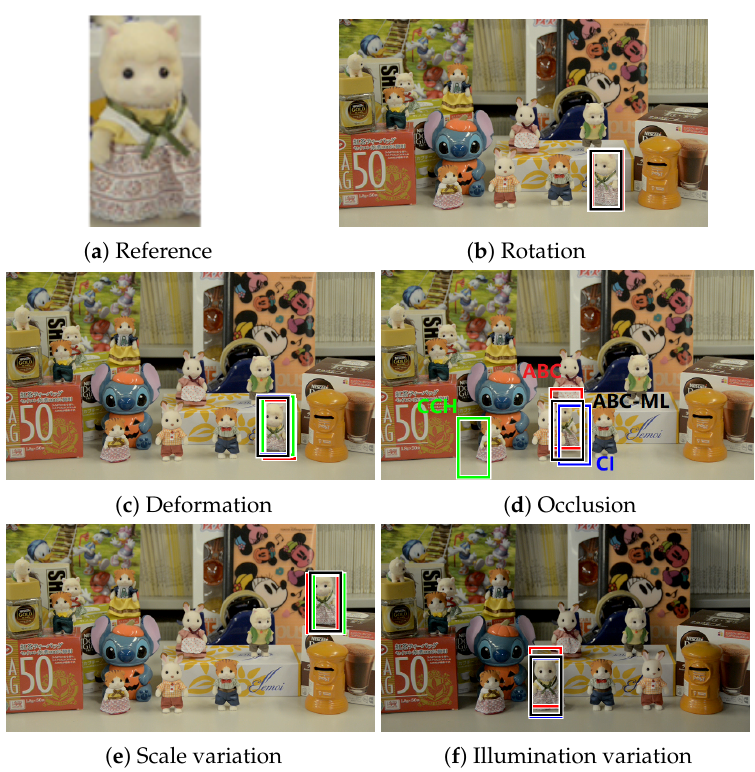
Figure 10. Comparison of color histogram-based matching methods. ( a ) Reference image. ( b – f ) show searching results by using different color histogram-based methods under different cases. Bounding blue, green, red, and black boxes are searching results by CI, CCH, ABC, and ABC-ML, respectively.